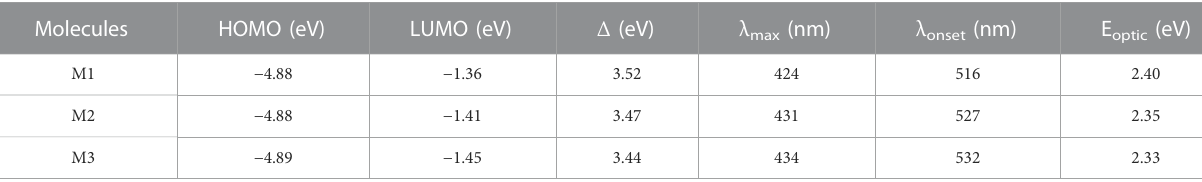
TABLE 2 The calculated energies of the frontier orbitals, HOMO-LUMO energy gap ( Δ ), λ max , λ onset, and optical band gap values (in THF) for the studied molecules. Molecules